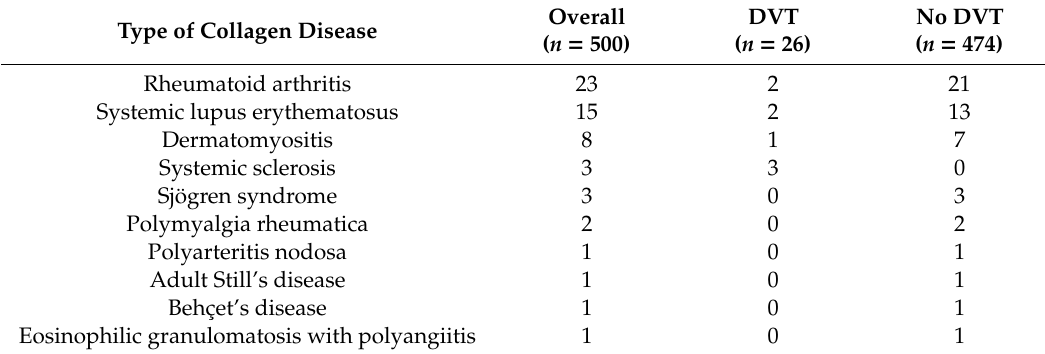
Table 2. Breakdown of collagen disease in each